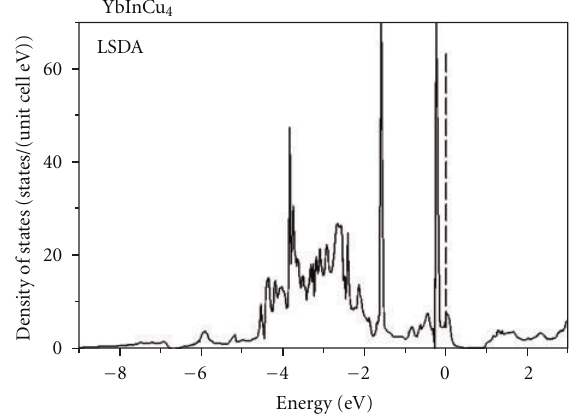
Figure 94: LSDA total DOS of YbInCu 4 in states/(unit cell eV) [475].